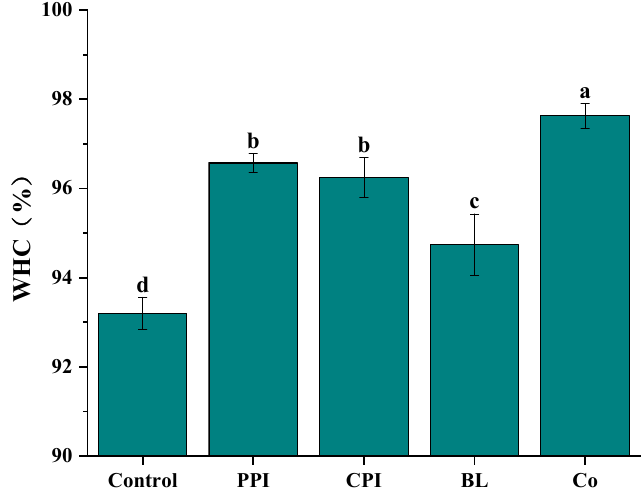
Figure 3. Effect of soybean oil with different protein pre-emulsification on the water retention of fish sausage. Note: Different letters indicate a significant difference between samples ( p < 0.05). The error bars represent the standard deviation ( n = 3).